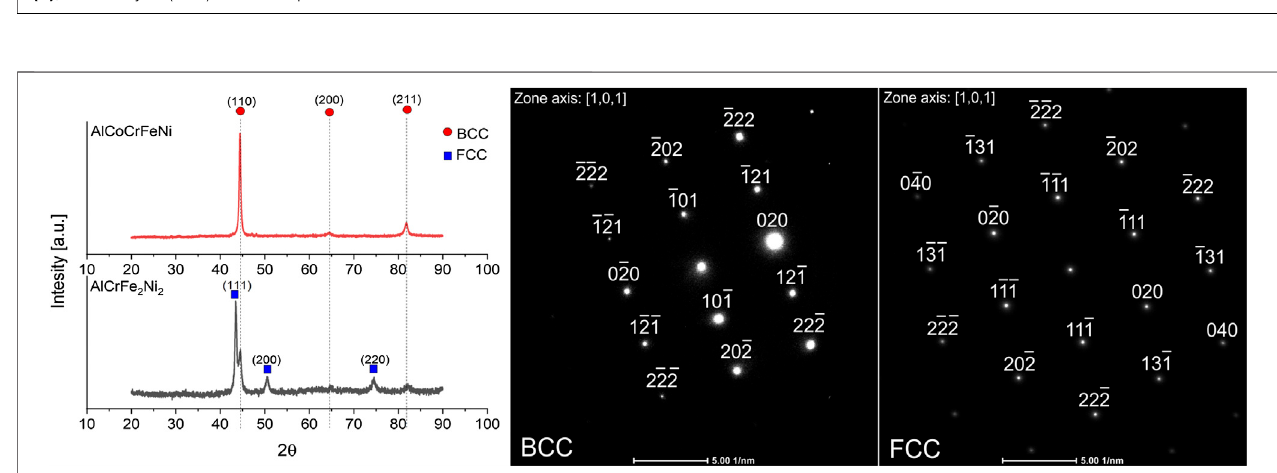
FIGURE 4 | X-ray (A) and electron (B) diffraction patterns con fi rming the occurrence of predominant phases in the investigated alloys.